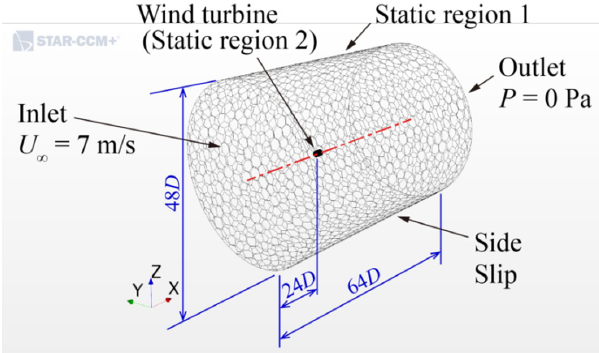
Figure 3. Whole domain of CFD computation and the boundary conditions.